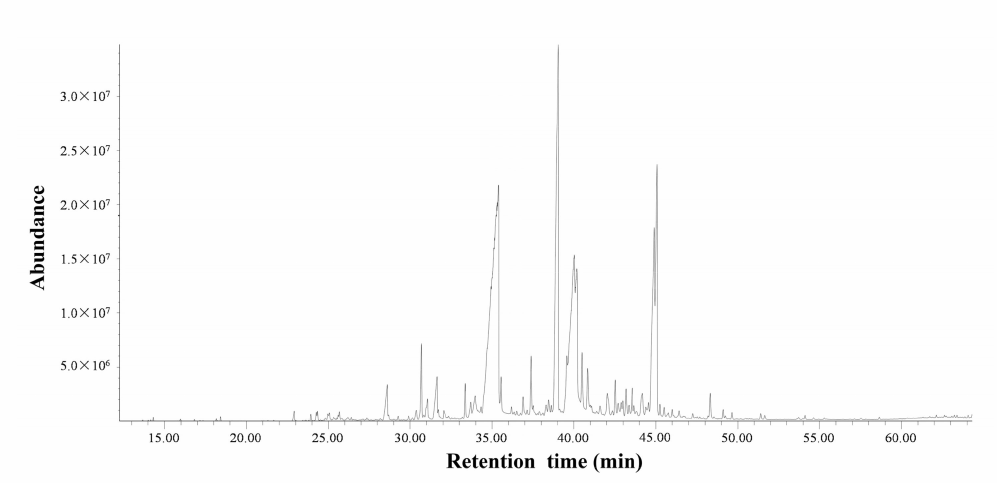
Figure 1. The GC-MS chromatogram of the essential